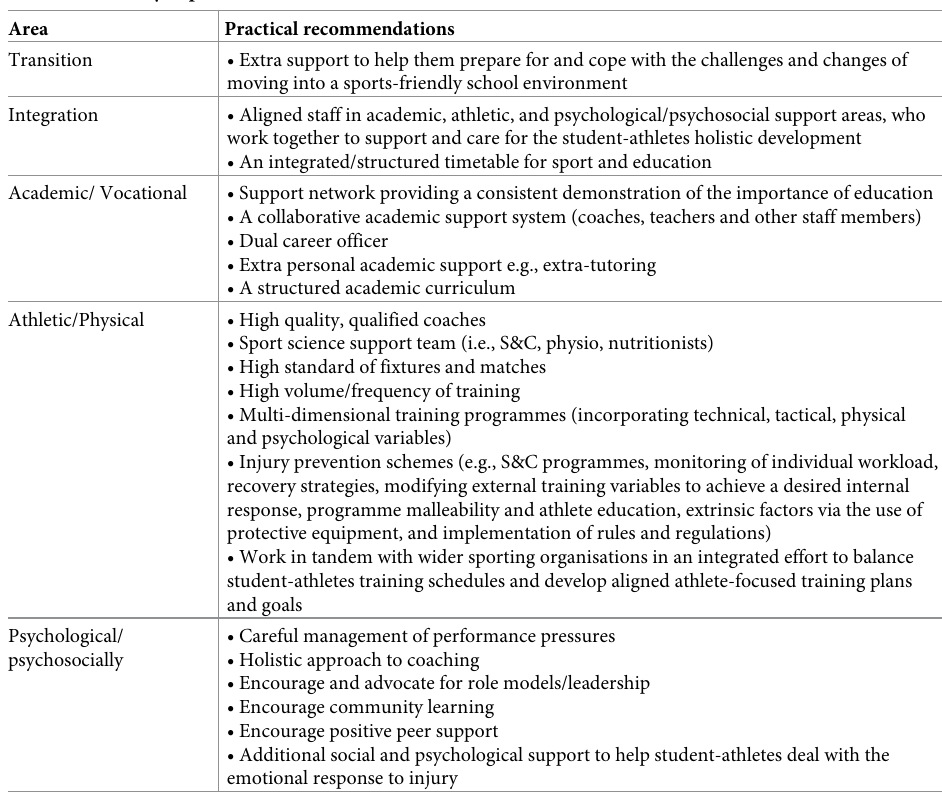
Table 1. Summary of practical